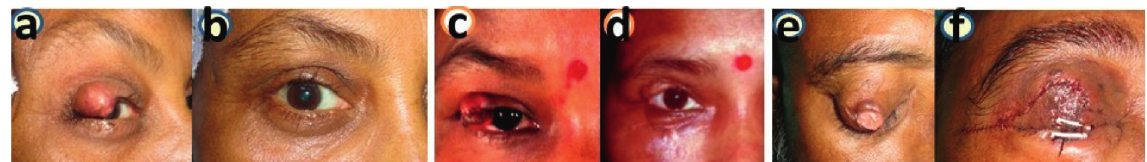
Figure 4: Preoperative and postoperative photographs of direct closure with canthotomy and cantholysis (a,b), semicircular flap (c,d), and preoperative with immediate images of the triangular flap (e,f).